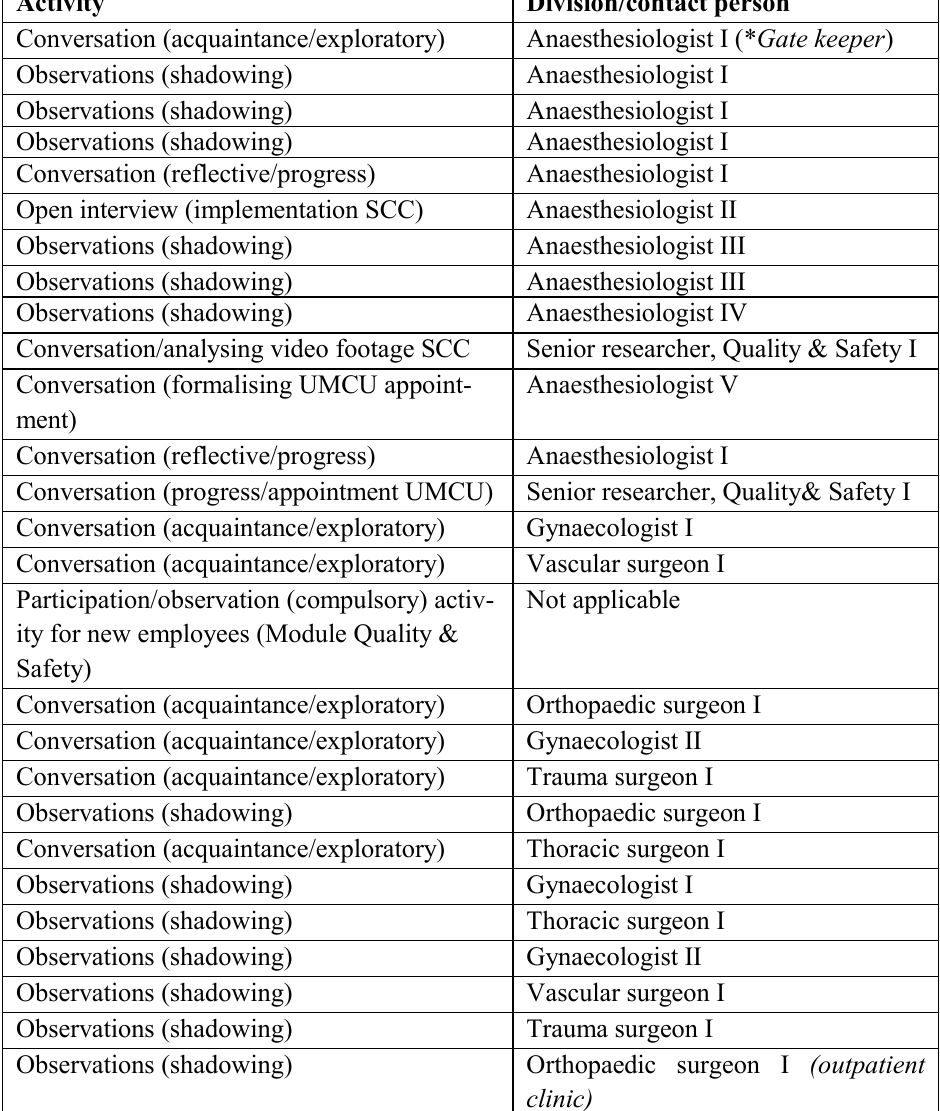
Table 1. Overview of the data